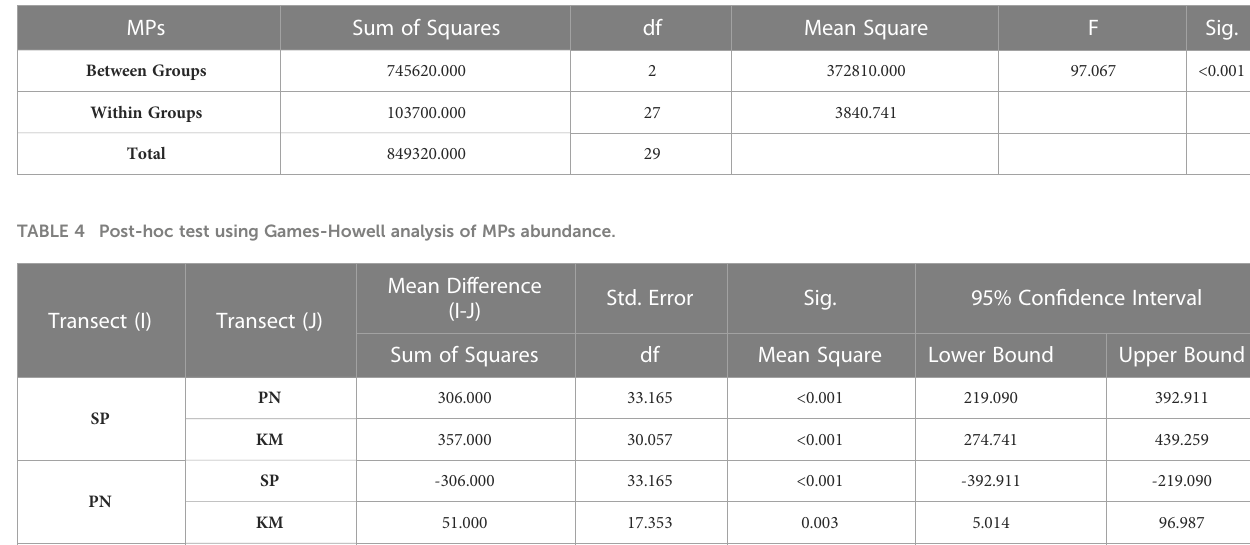
TABLE 3 One-way ANOVA output assessing MP abundance in estuarine sediment of three study sites.